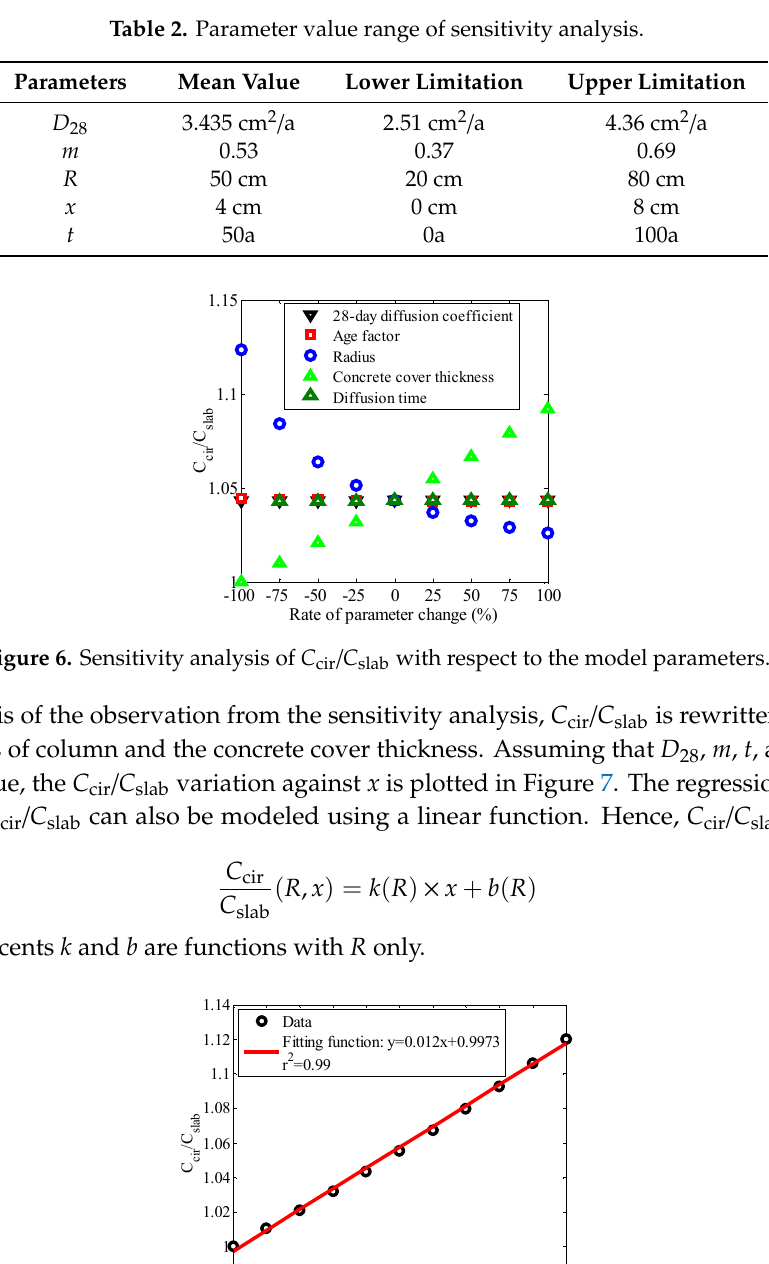
Table 2. Parameter value range of sensitivity analysis.